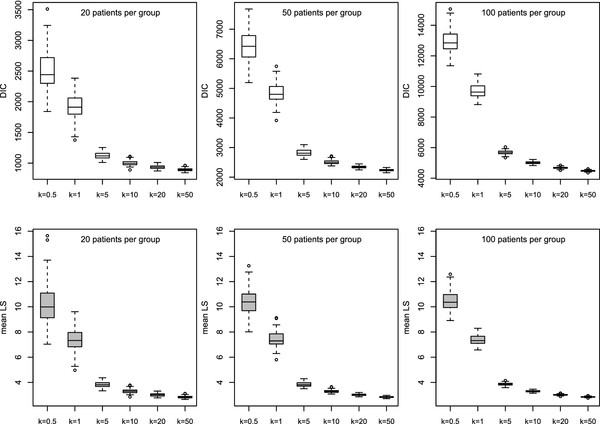
Vertigo data: PIT histograms for all candidate models. U-shaped histograms indicate under-dispersed predictive distributions, hump or inverse-U shaped histograms point at overdispersion, and skewed histograms occur when central tendencies are biased. Dashed gray lines show the histogram height corresponding to perfect calibration.